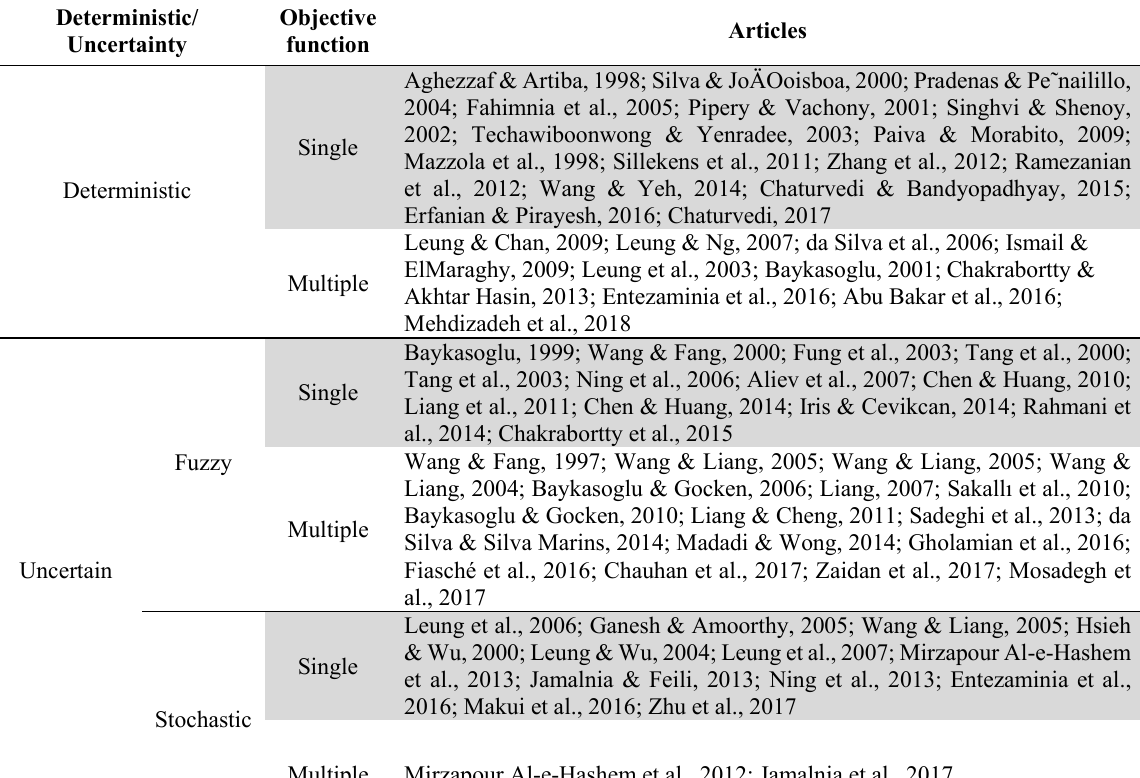
APP models classification based on the type of data (deterministic/fuzzy/stochastic) and the number of objective functions